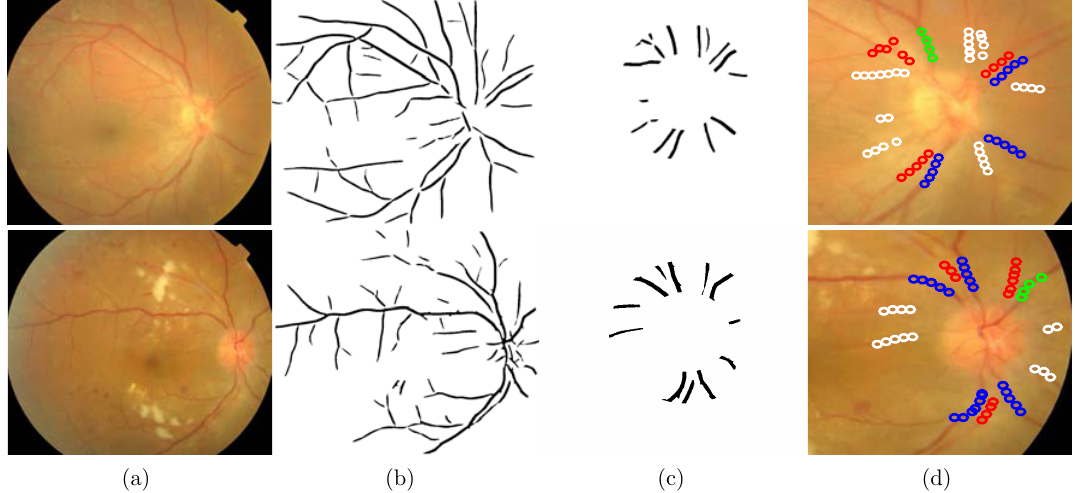
Fig. 22. Classi¯cation of retinal vessels (images taken from local database). (a) Original retinal images, (b) Vessel segmentation results, (c) Vessels inside RoI and (d) Classi¯ed retinal vessel portions (blue: vein, red: artery, white: neither artery or vein (unclassi¯ed), green: vein that has been wrongly classi¯ed as